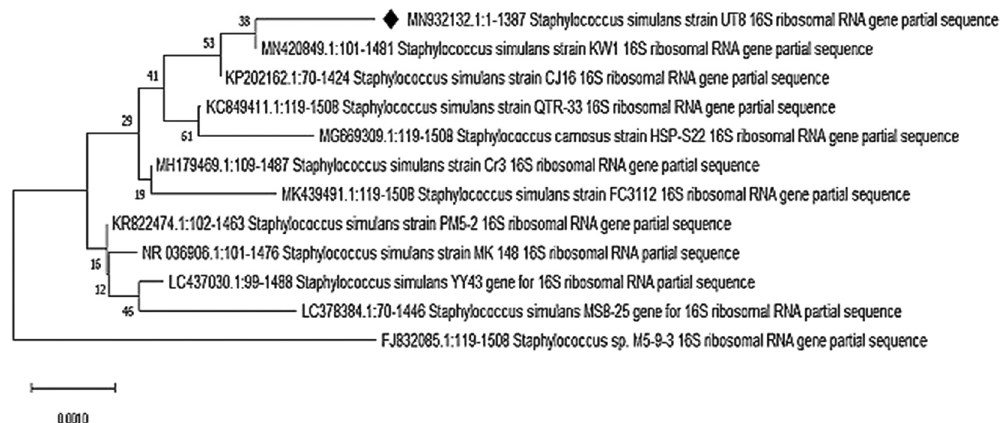
Figure 1: Phylogenetic tree of chromate - tolerant bacterium UT8 based on 16S rRNA gene sequencing and compared with other neighboring members of Staphylococcus